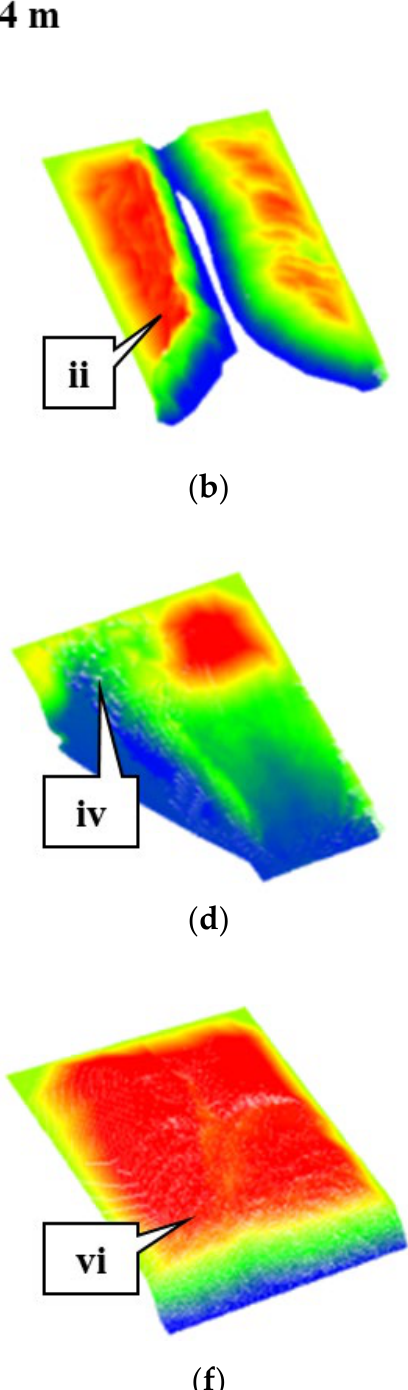
Figure 7. Digital surface models of Lebanon salt over 2021–2022 winter season ( a ) 23 November 2021, Digital Surface Model ( b ) 6 January 2022, Digital Surface Model ( c ) 26 January 2022, Digital Surface Model ( d ) 11 February 2022, Digital Surface Model ( e ) 31 March 2022, Digital Surface Model ( f ) 23 May 2022, Digital Surface Model.